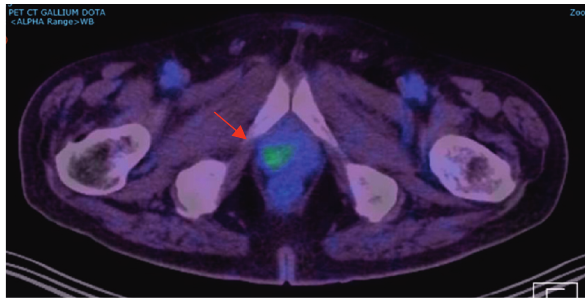
Figure 2: Ga68-DOTANOC PET/CT demonstrating increased DOTANOC avidity seen in the inferior aspect of the right side of the prostate gland (red arrow).